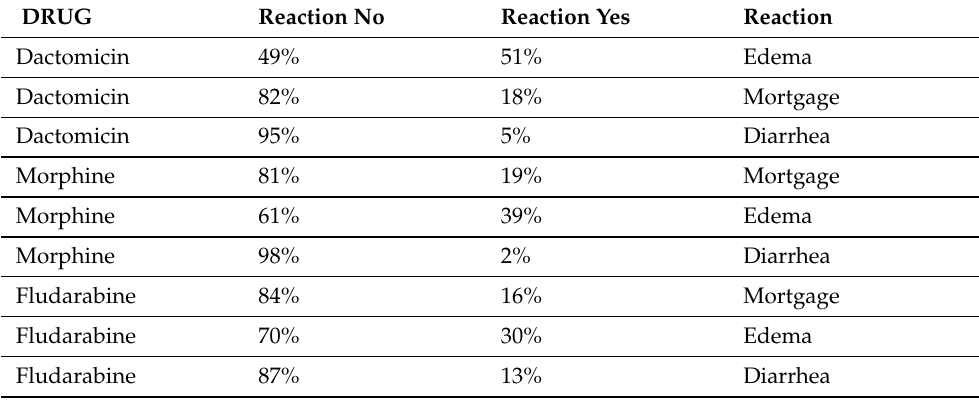
Table 1. DAG probabilities for drug–reaction.